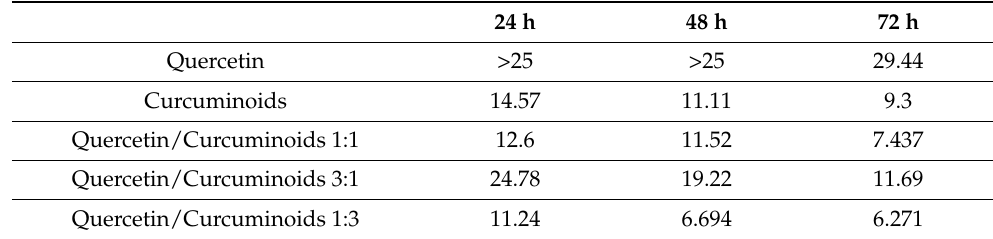
Figure 2. ( A ) ABTS radical scavenging activity of quercetin, curcuminoids and quercetin/curcuminoid mixtures. ( B ) Trolox equivalent antioxidant capacity (TEAC) of quercetin, curcuminoids and quercetin/curcuminoid mixtures. Table 2. The IC 50 values of quercetin, curcuminoids and 1:1, 3:1 and 1:3 quercetin/curcuminoid mixtures obtained from DPPH and ABTS assay.